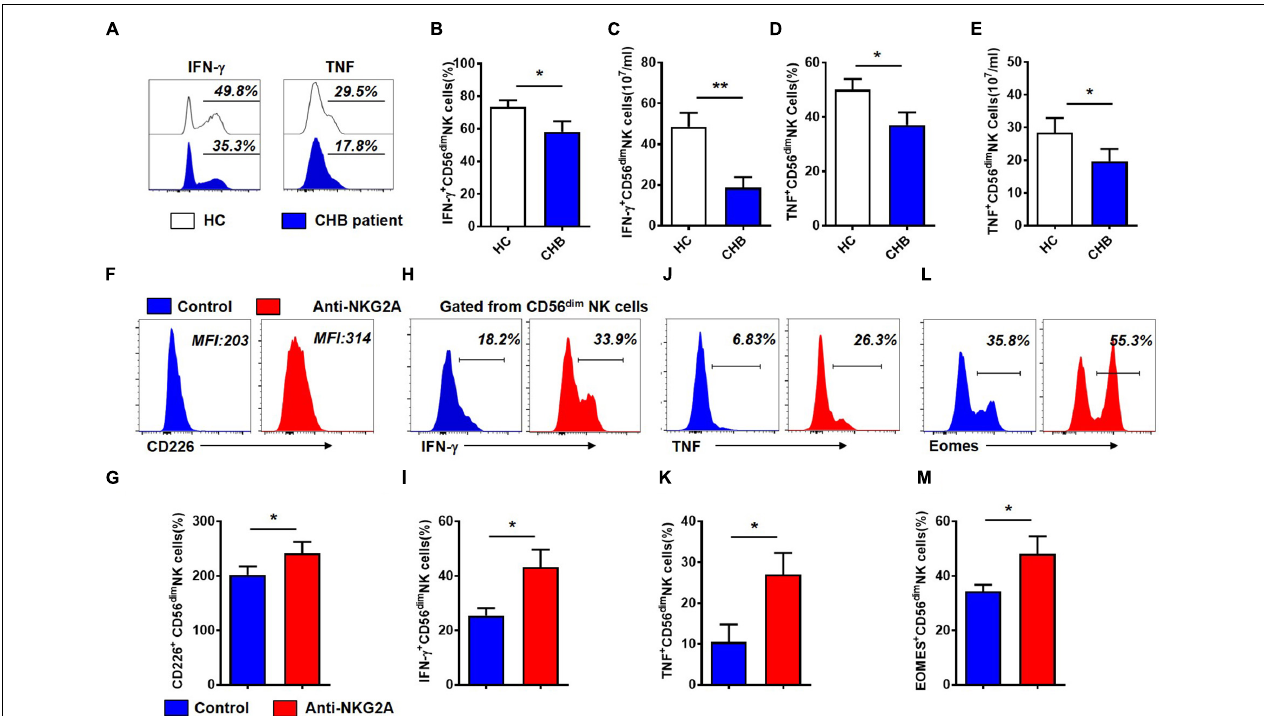
FIGURE 3 | Cytokine production by CD56 dim NK cells is restored after blockade of NKG2A signaling in patients with CHB . (A) Representative flow cytometry plots showing IFN- γ and TNF expression in NK cells from patients with CHB and healthy controls. (B) Analysis of IFN- γ + CD56 dim NK cells in patients with CHB and healthy controls. (C) Comparison of absolute numbers of IFN - γ + CD56 dim NK cells in patients with CHB and healthy controls. (D) Analysis of TNF + CD56 dim NK cells in patients with CHB and healthy controls. (E) The absolute number of TNF + CD56 dim NK cells in patients with CHB and healthy controls. (F–M) NK cells isolated from patients with CHB were cultured in DMEM supplemented with 10% FBS and 100 IU/ml IL-2, with anti-human NKG2A antibody or control IgG. After 3 days, the phenotype and function of NK cells were analyzed by flow cytometry. (F) Representative plots of NKG2A and CD226 expressed in CD56 dim NK cells after NK cells were cultured with anti-human NKG2A antibody or control IgG. (G) Expression of CD226 on total NK cells, CD56 bright and CD56 dim NK cells after isolated CHB NK cells were cultured with anti-human NKG2A antibody or control IgG. (H) Representative plots of IFN- γ expressed in CD56 dim NK cells after NK cells were cultured with anti-human NKG2A antibody or control IgG. (I) Expression of IFN- γ on total NK cells, CD56 bright and CD56 dim NK cells after isolated CHB NK cells were cultured with anti-human NKG2A antibody or control IgG. (J) Representative plots of TNF expressed in CD56 dim NK cells after NK cells were cultured with anti-human NKG2A antibody or control IgG. (K) Expression of TNF on total NK cells, CD56bright and CD56 dim NK cells after isolated CHB NK cells were cultured with anti-human NKG2A antibody or control IgG. (L) Representative plots of Eomes expressed in CD56 dim NK cells after NK cells were cultured with anti-human NKG2A antibody or control IgG. (M) Expression of Eomes on total NK cells, CD56 brigh t and CD56 dim NK cells after isolated CHB NK cells were cultured with anti-human NKG2A antibody or control IgG. Results are presented as the mean ± SEM ( n ≥ 3 per group) and unpaired/paired two-tailed Student’s t -tests were conducted; * p < 0.05, ** p < 0.01. N.S., not